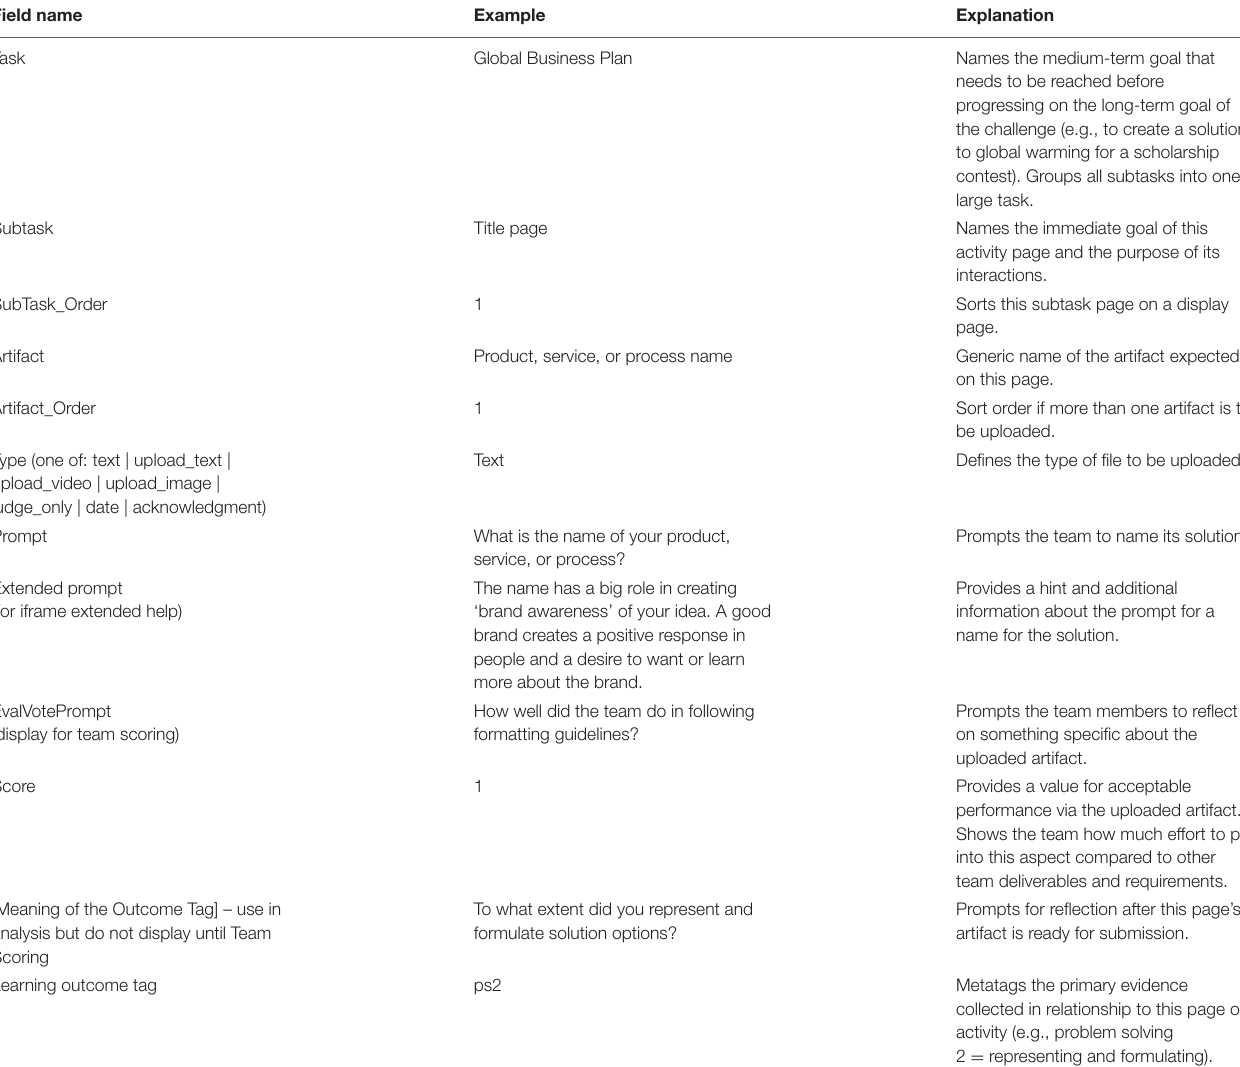
TABLE 3 | Fields and content for a subtask in Balance of the Planet ‘Global Business Plan’